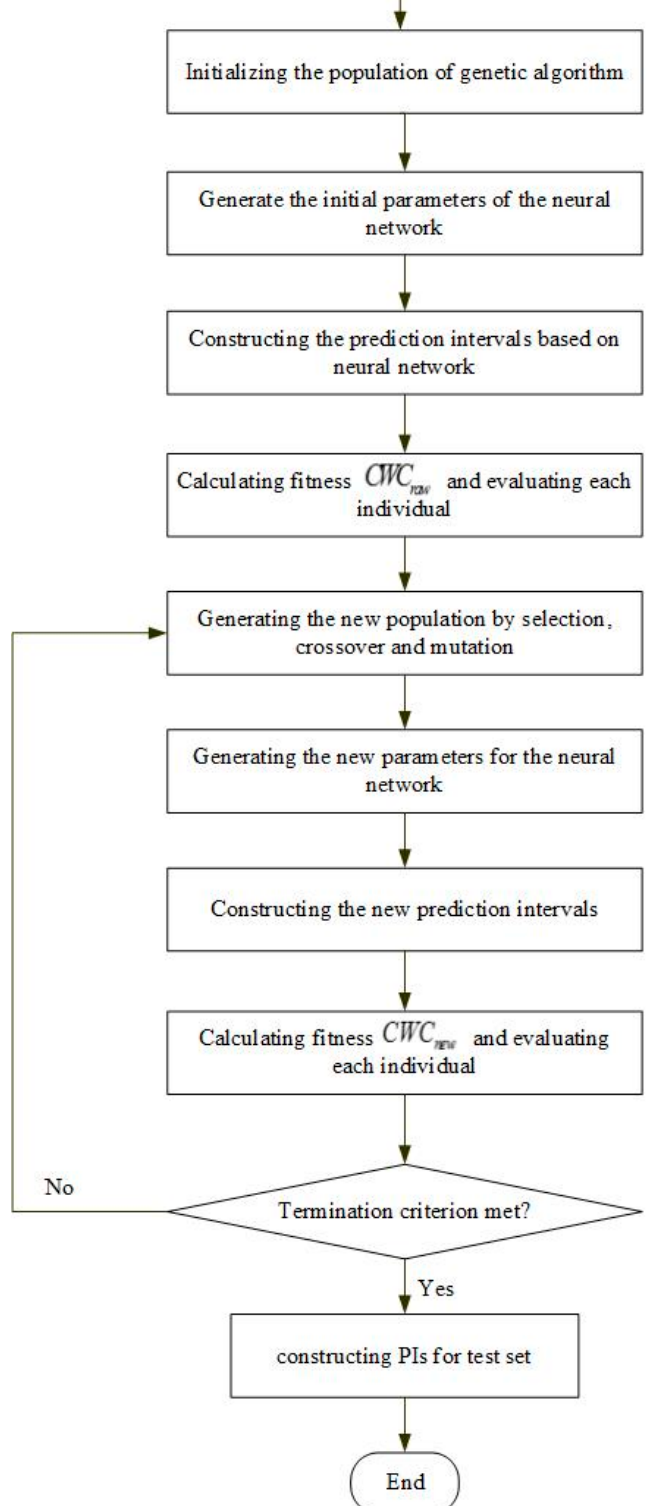
Figure 1. The flowchart of a typical NN-based lower–upper bound estimation (LUBE) approach.